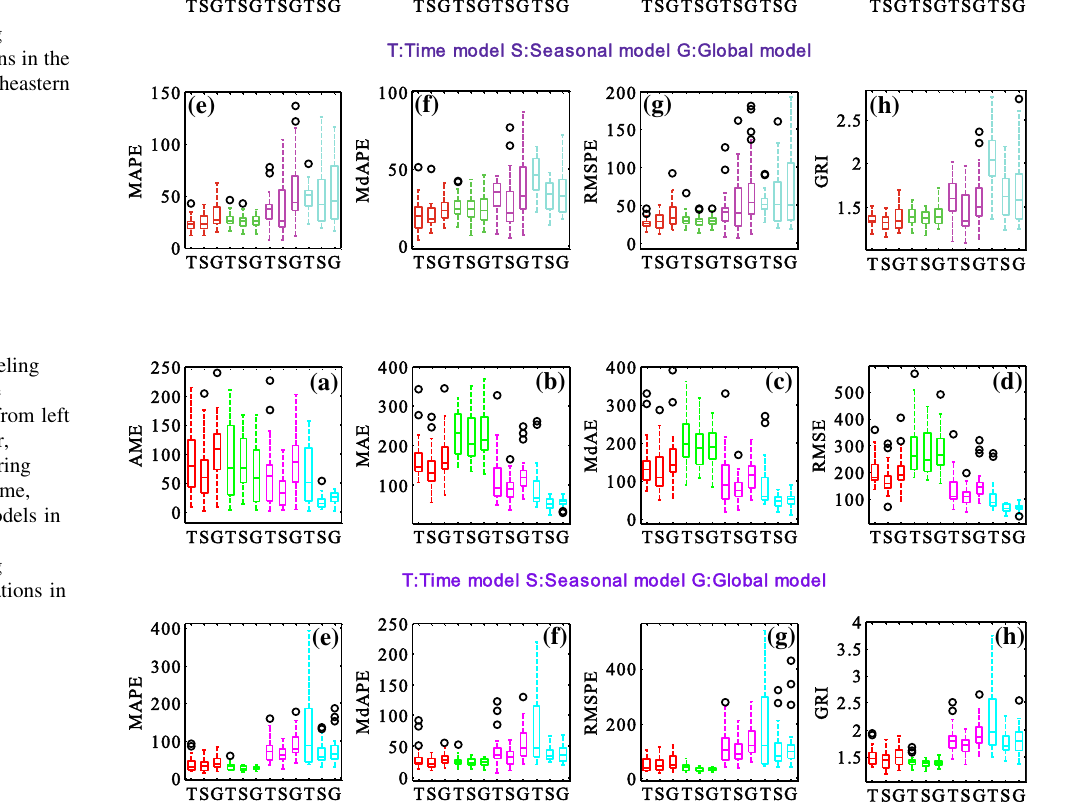
practice—for example, MAPE and RMSPE—indicate that the seasonal model was better than the time model in terms of forecasting accuracy.